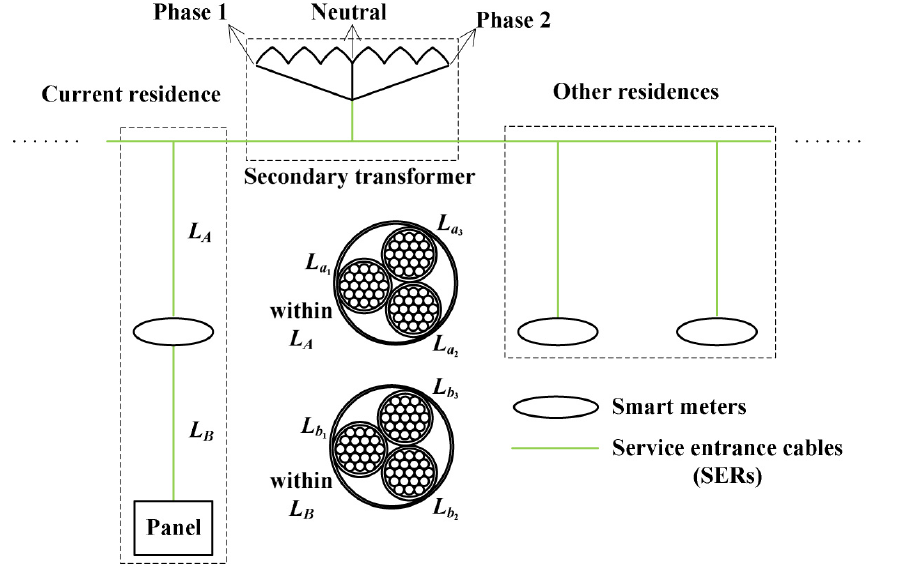
Figure 3. The topology above the